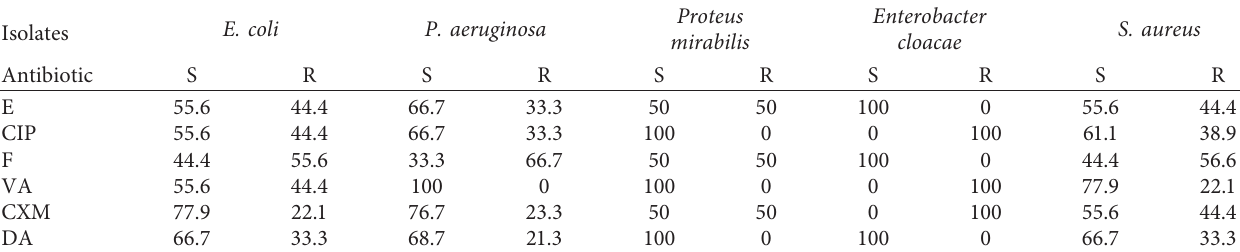
Table 6: Sensitivity testing of used antibiotic